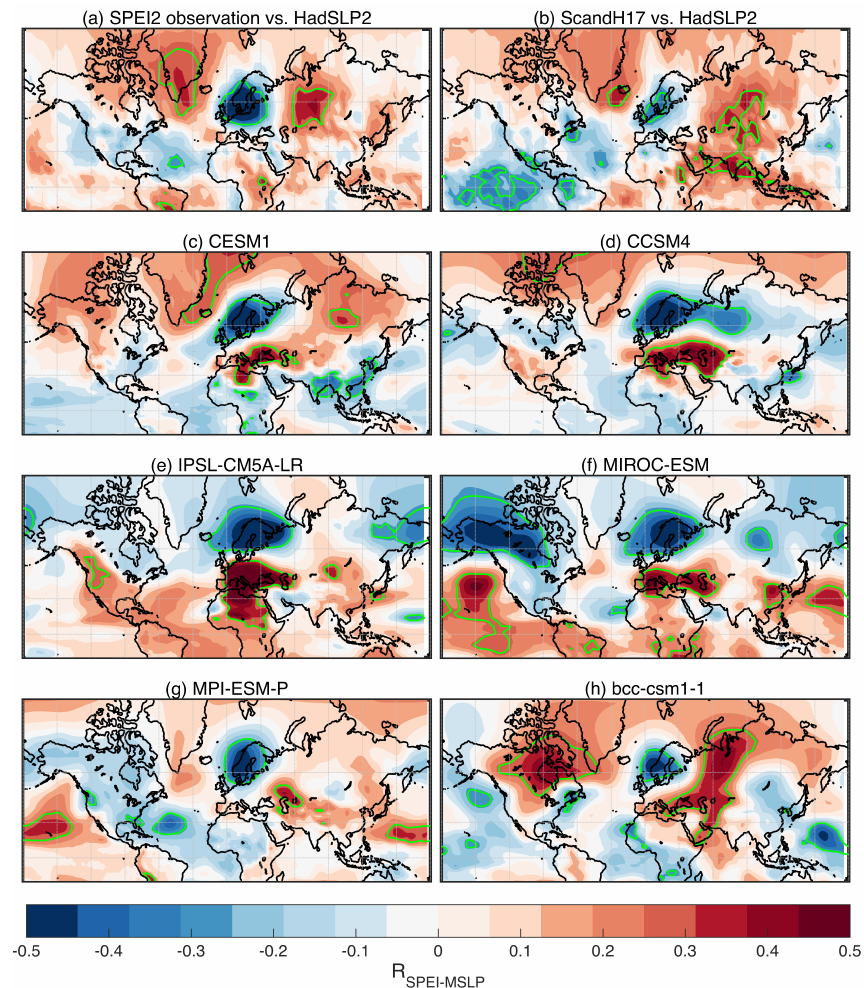
Figure 5. Spatial distribution of the correlation coefficient of the northern European warm-season hydroclimate and mean sea level pres- sure (MSLP). Association between regional drought index and sea level pressure over the 1950–1995 period. Results based on (a) observa- tions, (b) ScandH17, and (c) – (g) the model (including r1i1p1 ensemble only). Regions with significant ( p < 0.05) correlations are outlined in green